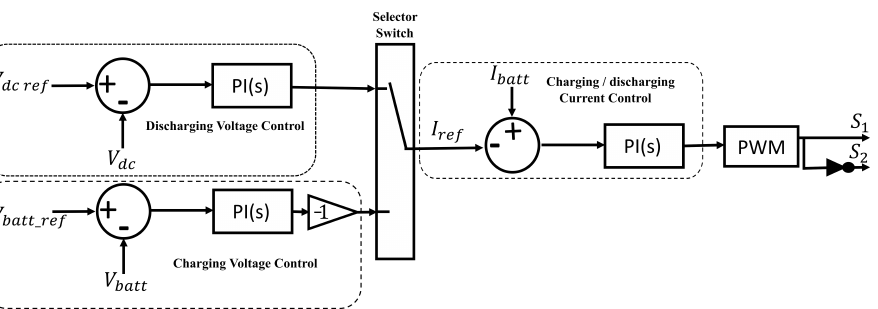
Figure 6. Block diagram of EV charging or discharging selection and control [21], © 2021